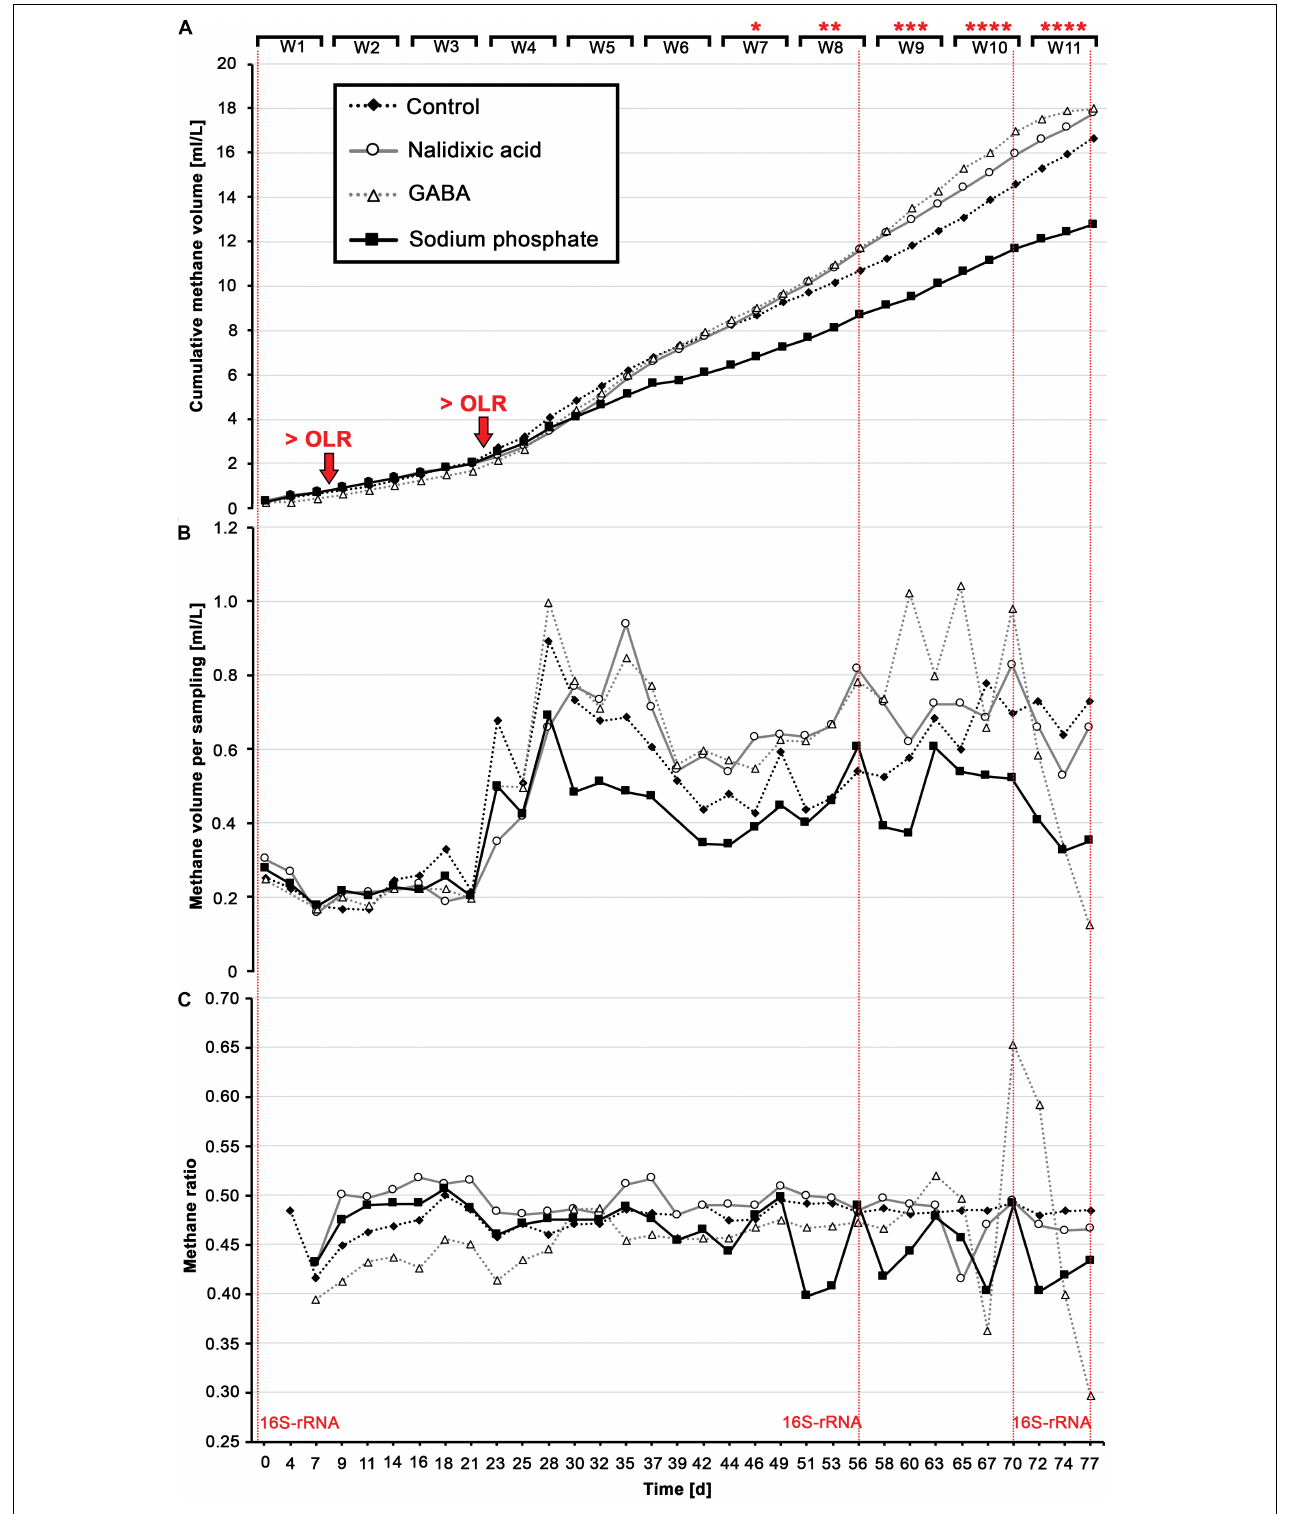
FIGURE 2 | Produced biogas: Cumulative methane (A) , the amount of methane per sampling day (B) and the ratio of methane to total biogas for each sampling day (C) are shown for all four digesters in response to perturbation with nalidixic acid, γ -aminobutyric acid (GABA) and sodium phosphate. The fourth reactor acted as a control, with no inhibiting substances. Organic loading rates (OLR) were increased after week 1 (0.43 g/L d - 1 ) and after week 3 (1.29 g/L d - 1 ). At days 0, 56, 70, and 77, 16S-rRNA gene samples were taken for all four reactors (highlighted with horizontal lines in red).